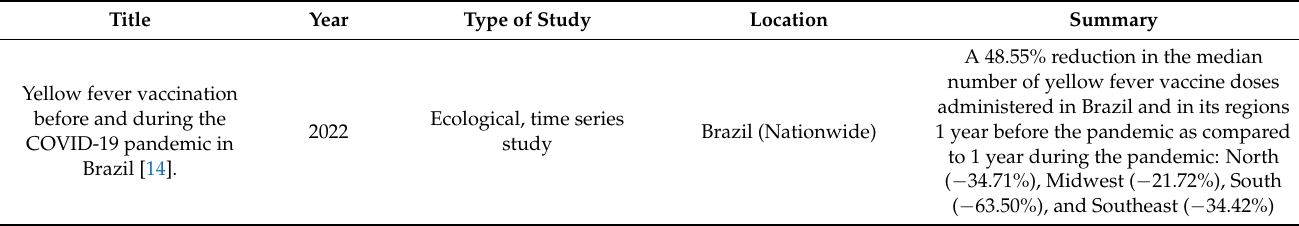
Yellow fever vaccination before and during the COVID-19 pandemic in Brazil